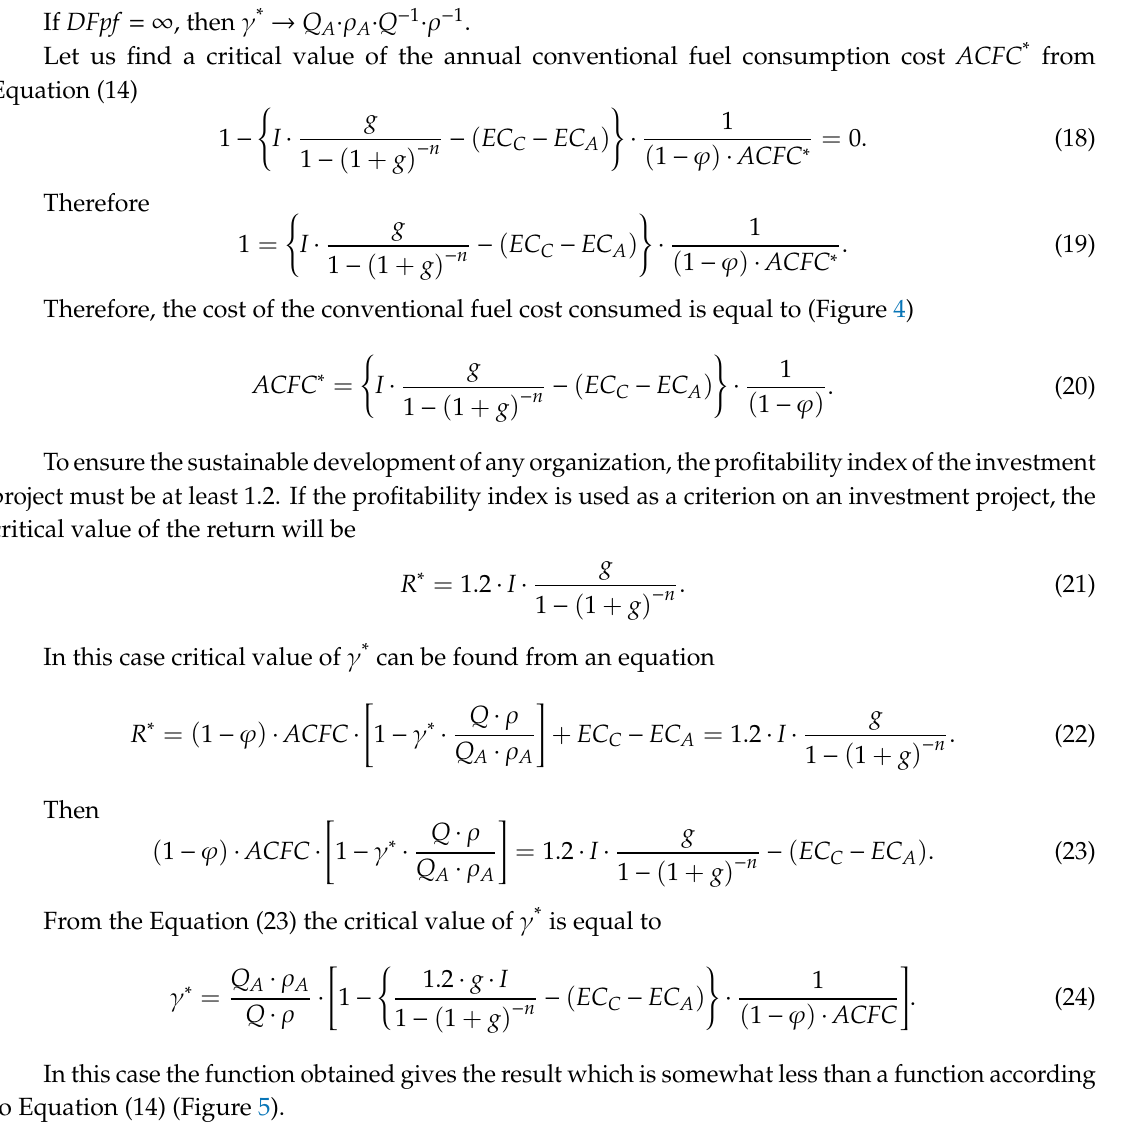
Figure 4. The dependence on the ratio of alternative fuel price to conventional fuel price on the annual conventional fuel consumption cost (criterion— NPV ).